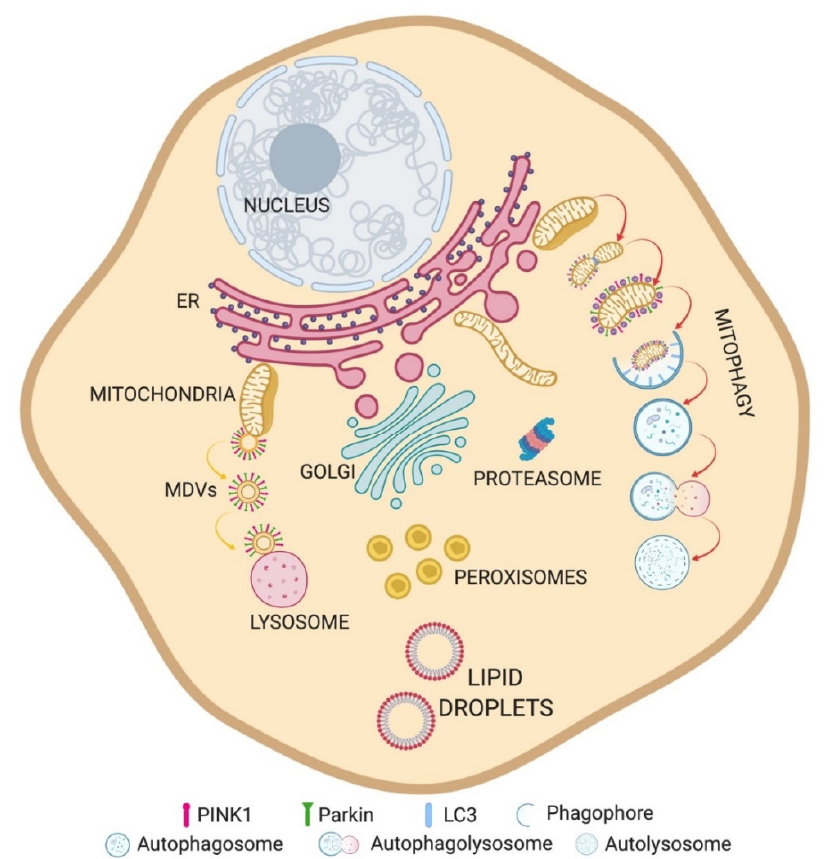
Figure1. Overviewoforganellecrosstalks. Figure 1. Overview of organelle crosstalks. Schematic representation of organelles and their relationships.